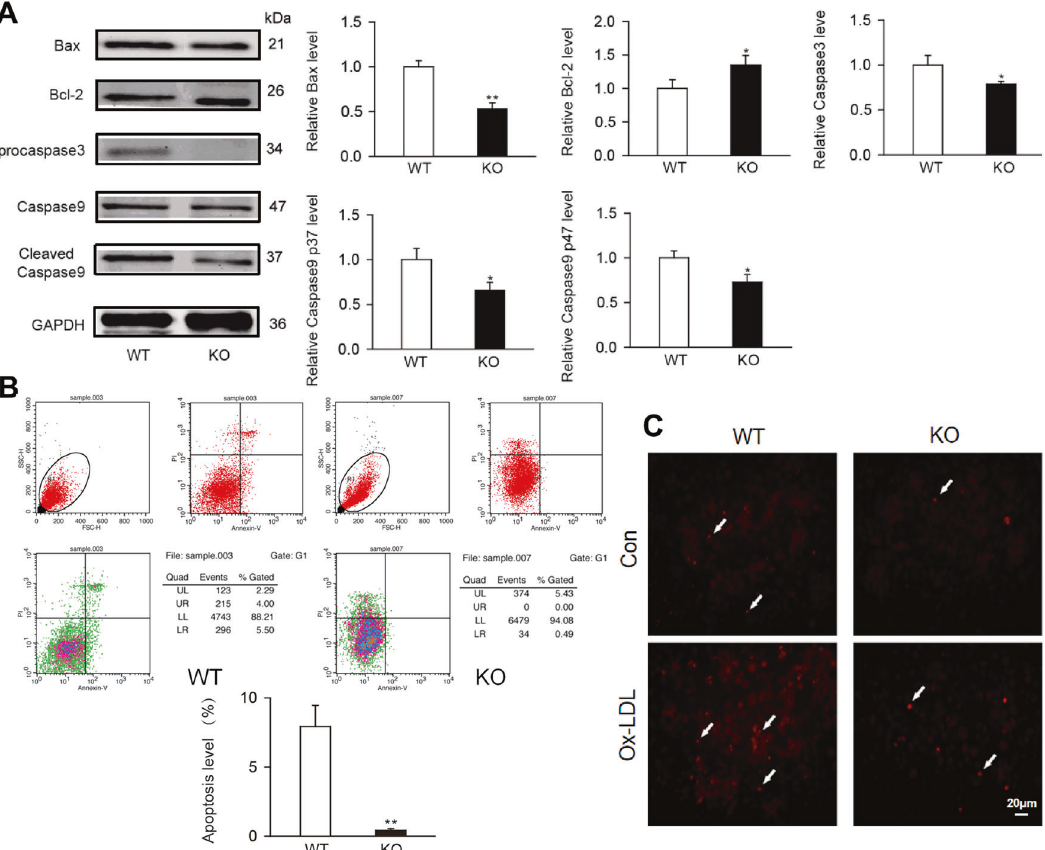
Fig. 5 Swiprosin-1 de fi ciency inhibited macrophages apoptosis. A Representative Western blot for ox-LDL induced apoptosis-related protein expression in primary peritoneal macrophages from Swp − / − and WT mice (left) and densitometric analysis (right). GAPDH served as the loading control. Data are presented as the mean ± SE; * P < 0.05, ** P < 0.01; n = 3 per group. B Apoptosis in primary peritoneal macrophages induced by ox-LDL was detected by Annexin V-FITC/PI apoptosis detection kit using fl ow cytometry. Data are presented as the mean ± SE; * P < 0.05, n = 3 per group. C Representative images of apoptosis in primary peritoneal macrophages detected by TUNEL kit (upper) and quantitative analysis (down). Data are presented as the mean ± SE; * P < 0.05, n =